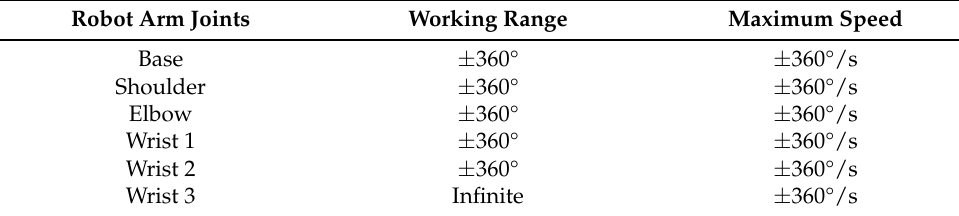
Table 2. Working range and speed of the UR3 robot joints.